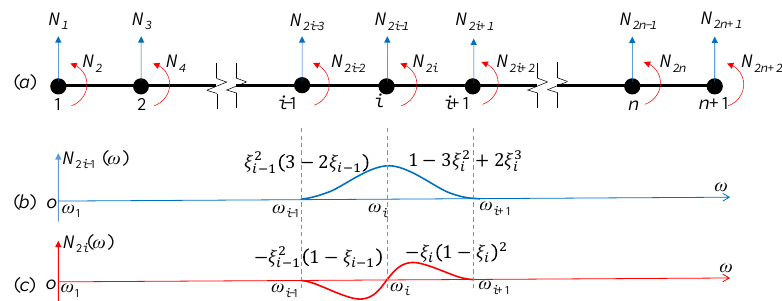
Figure 3. Basic principle of the shape function method. ( a ) Division of the curve; ( b ) The shape function corresponding to the unit vertical deformation; ( c ) The shape function corresponding to the unit rotational angle.